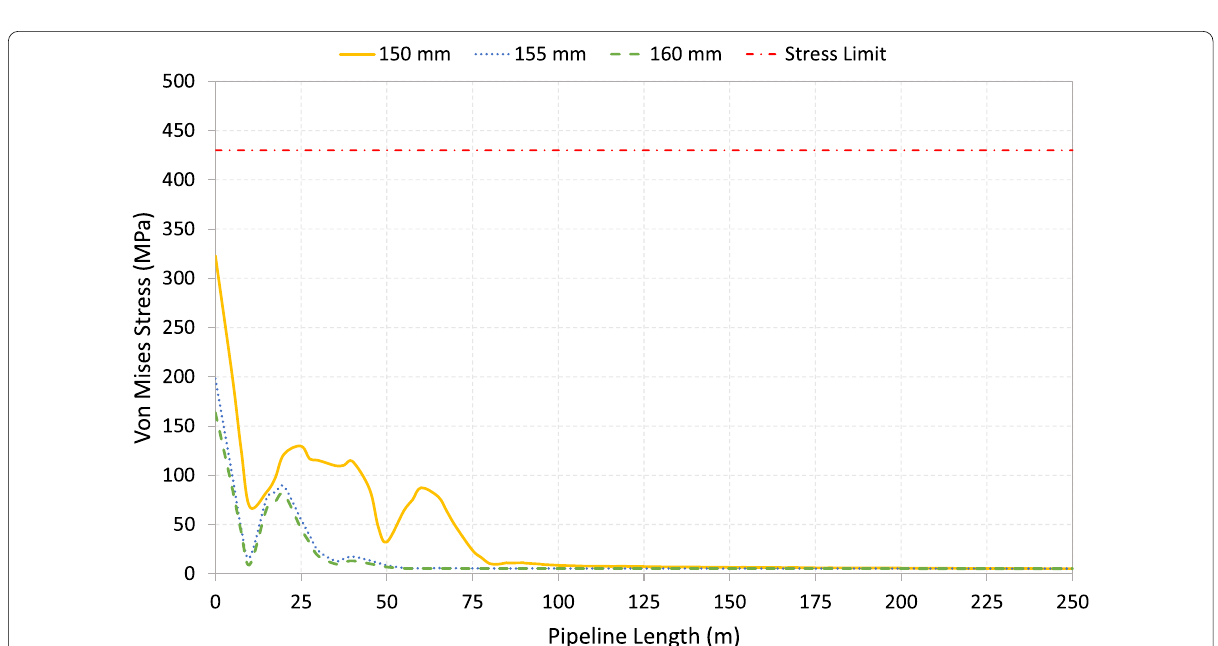
Fig. 6 Envelopes of the von Mises stresses of the pipeline for concrete thickness range 150–160 mm (1-year RPV wave